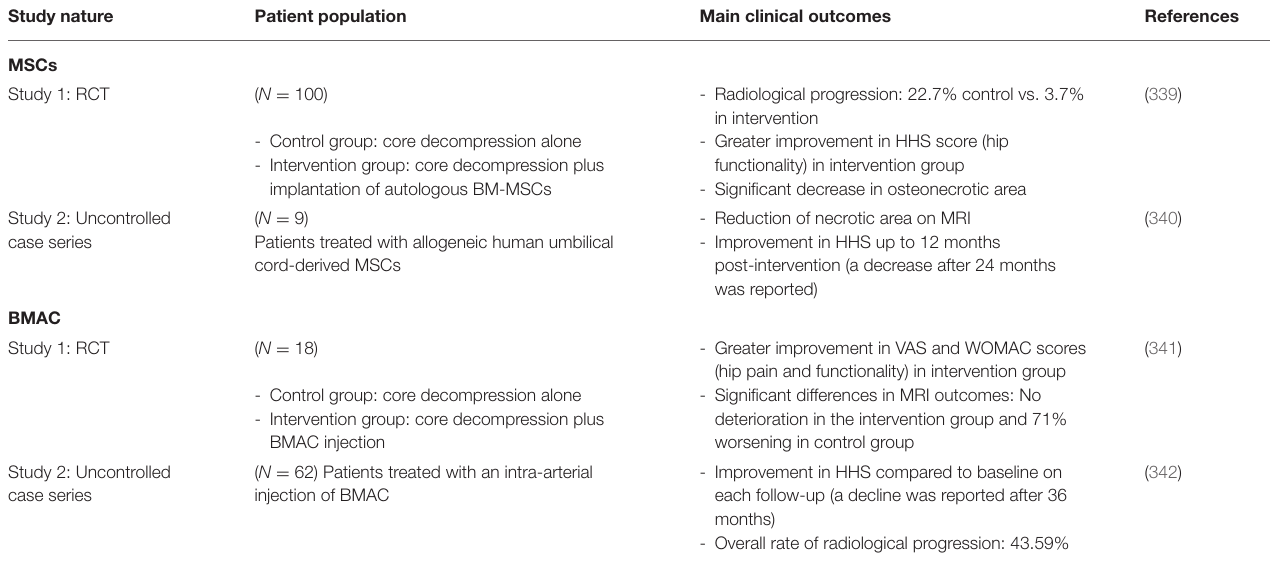
TABLE 2 | Select studies using MSCs or BMAC for treatment of osteonecrosis of the femoral head. Study